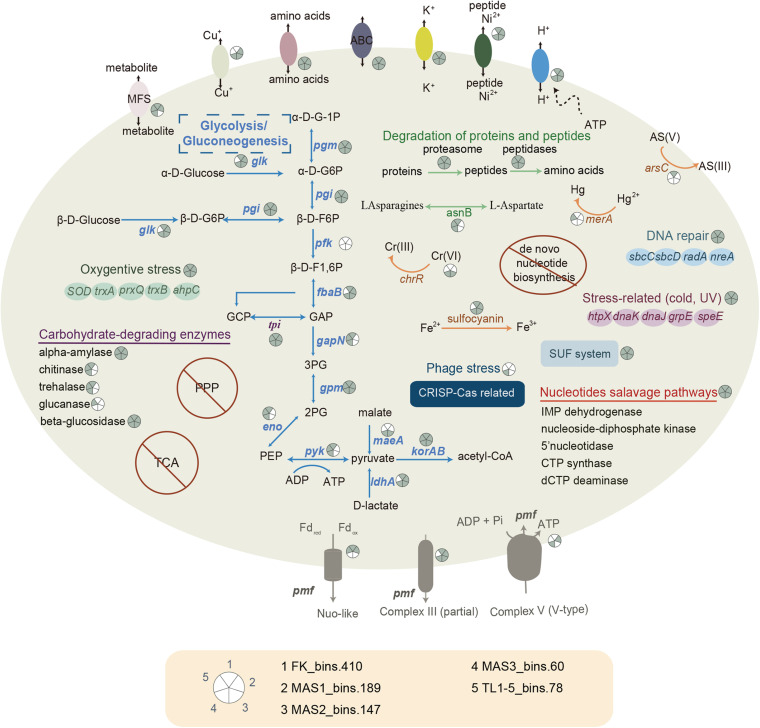
Reconstructed metabolic pathways of newly recovered Parvarchaeota MAGs. α-D-G, α-D-glucose; β-D-G, β-D-glucose; β-D-F, β-D-fructose; GCP, glycerone-P; GAP, glyceraldehyde-3P; 3PG, glycerate-3P; 2PG, glycerate-2P; PEP, phosphoenolpyruvate; Fdox, oxidized ferredoxin; Fdred, reduced ferredoxin; pmf, proton motive force. For detailed on pathways, see Supplementary Table 9.